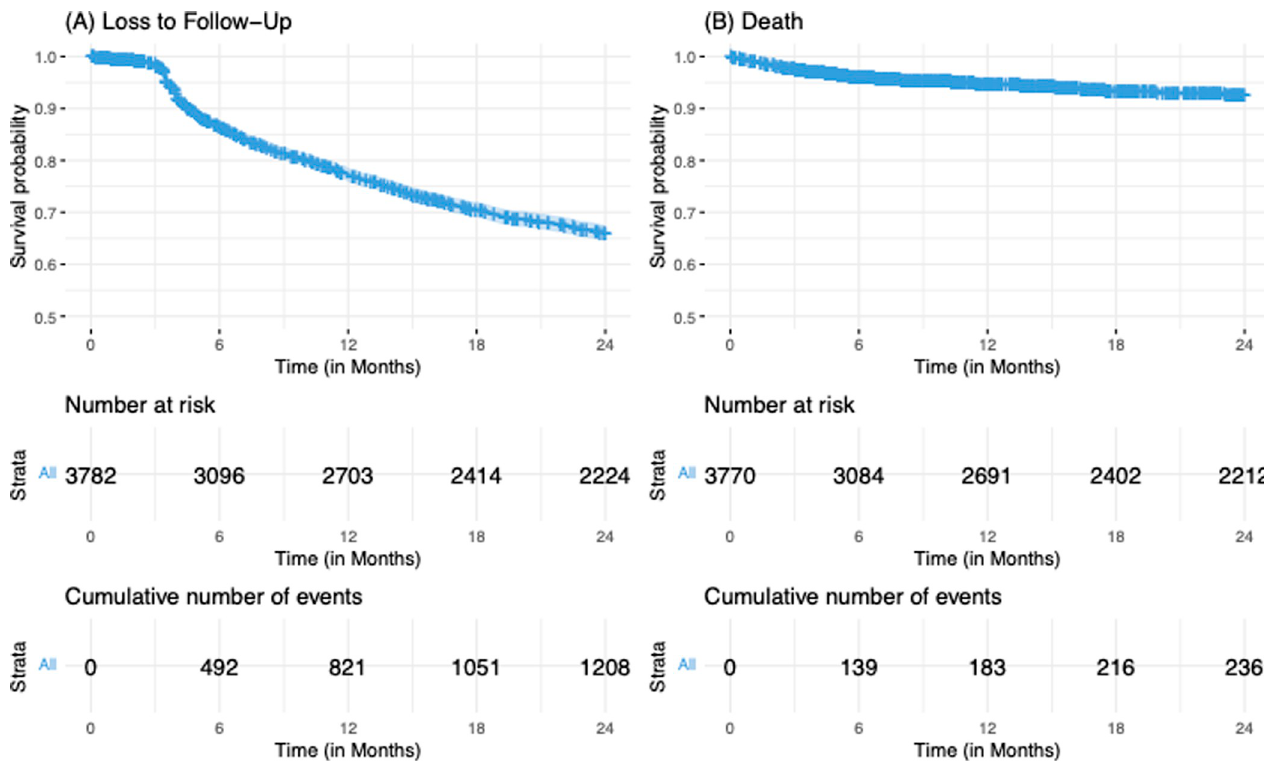
Fig 3. Kaplan-Meier probability of loss-to-follow-up and death among patients who were registered in 2016 and 2017 and followed for 24 months.